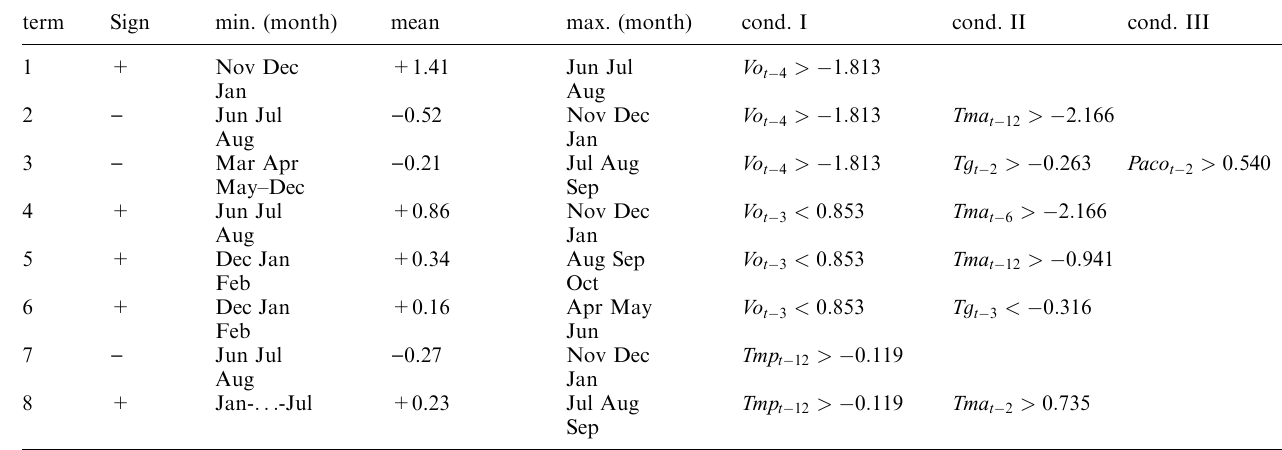
Table 3. Simultaneous conditions to be fulfilled in order that a given term of the model be ‘‘switched on’’. In columns 2, 3, 4 and 5, sign, minimum, mean and maximum value of each contribution are